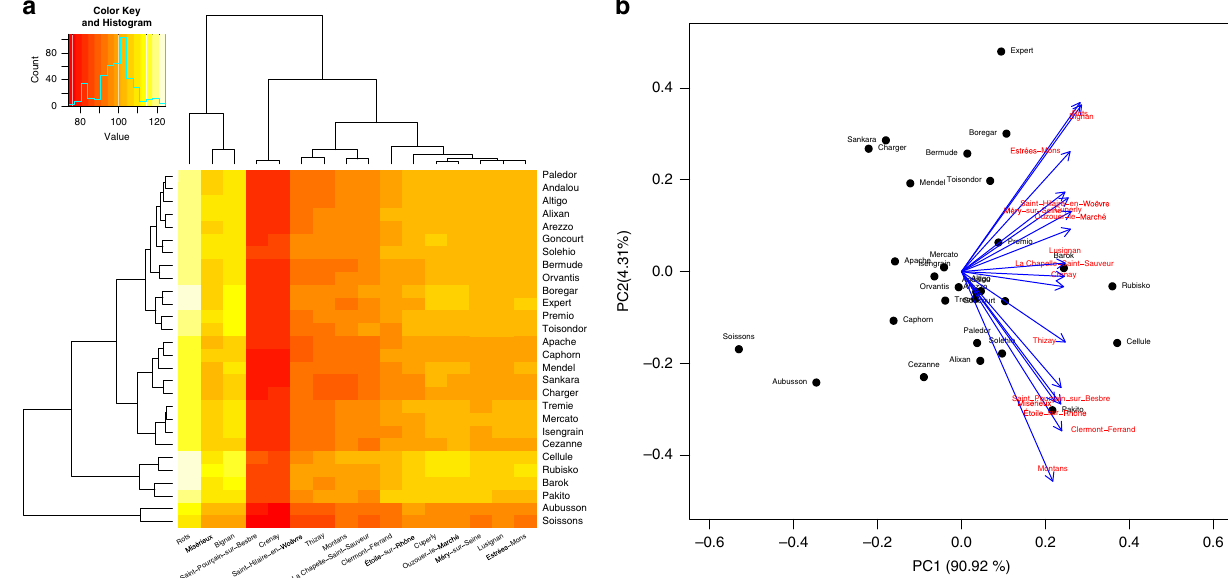
Fig. 5 Predicted grain yield for selected genotypes in target locations. a Heatmap of expected grain yield (average from 16 years, 2000 – 2015 of weather data), and b biplot analysis of the predicted